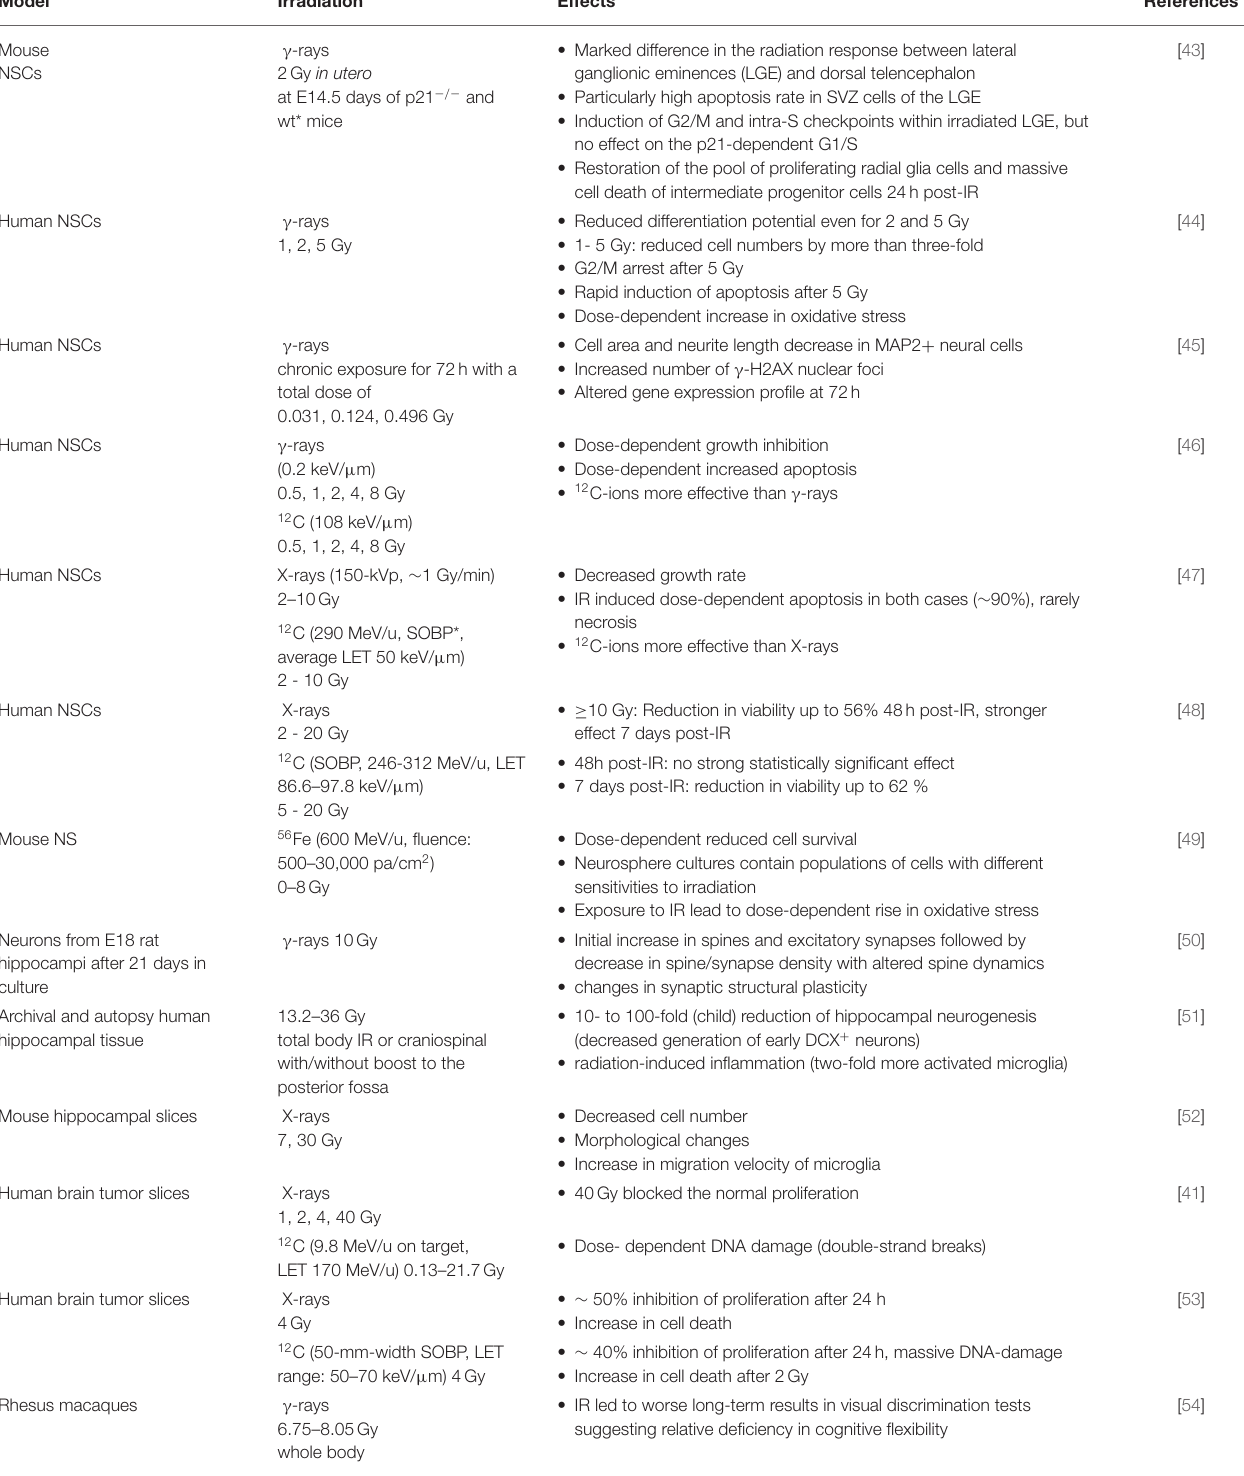
TABLE 1 | Data collection of in vitro and in vivo studies on the effects of